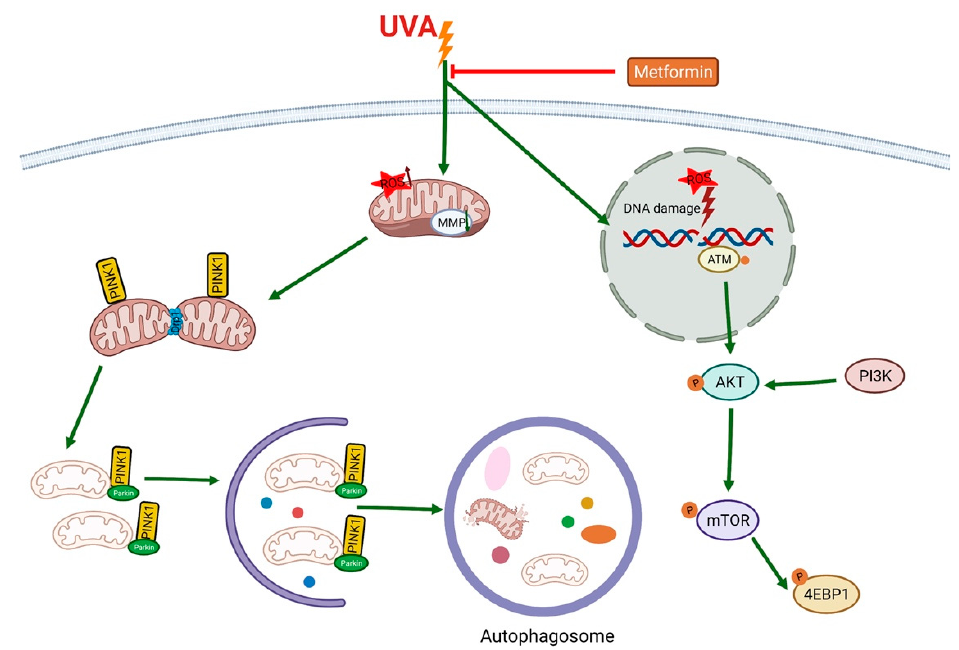
Figure 8. UVA increases mitochondrial ROS levels and decreases mitochondrial membrane poten ‐ tial, leading to mitophagy, and induces DNA damage and activates PI3K/AKT/mTOR signaling pathway, which causes cell senescence, while metformin suppresses mitochondrial damage, mi ‐ tophagy, and PI3K/AKT/mTOR signaling pathway response to UVA ‐ induced